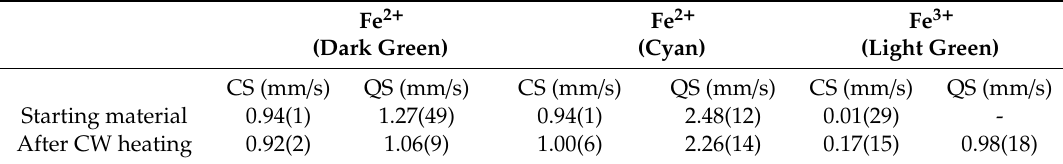
Figure 1. Fitted Synchrotron Mössbauer Source (SMS) spectra of ferropericlase at ambient pressure, after synthesis. The red solid lines show the theoretical fit of the data points (black dots) and the residuals are indicated above the spectra (red dots). Dark green and cyan doublets correspond to Fe 2+ components and the light green singlet corresponds to the Fe 3+ component. The fitting parameters are presented in detail in Table 1. Table 1. Fitted parameters of center shift (CS) and quadrupole splitting (QS) of ferropericlase crystal C03 of Experiment 1 at 30 GPa, before heating and after being heated continuously.